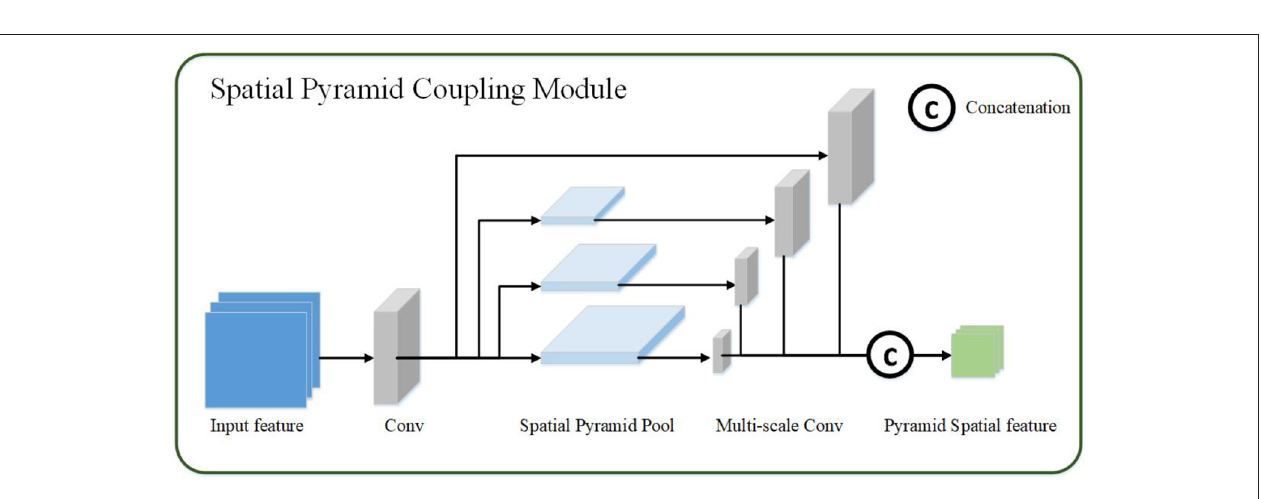
FIGURE 3 | The spatial pyramid coupling module. The spatial pyramid coupling module utilizes spatial pyramid pooling to get multi-scale feature maps and concatenate them.